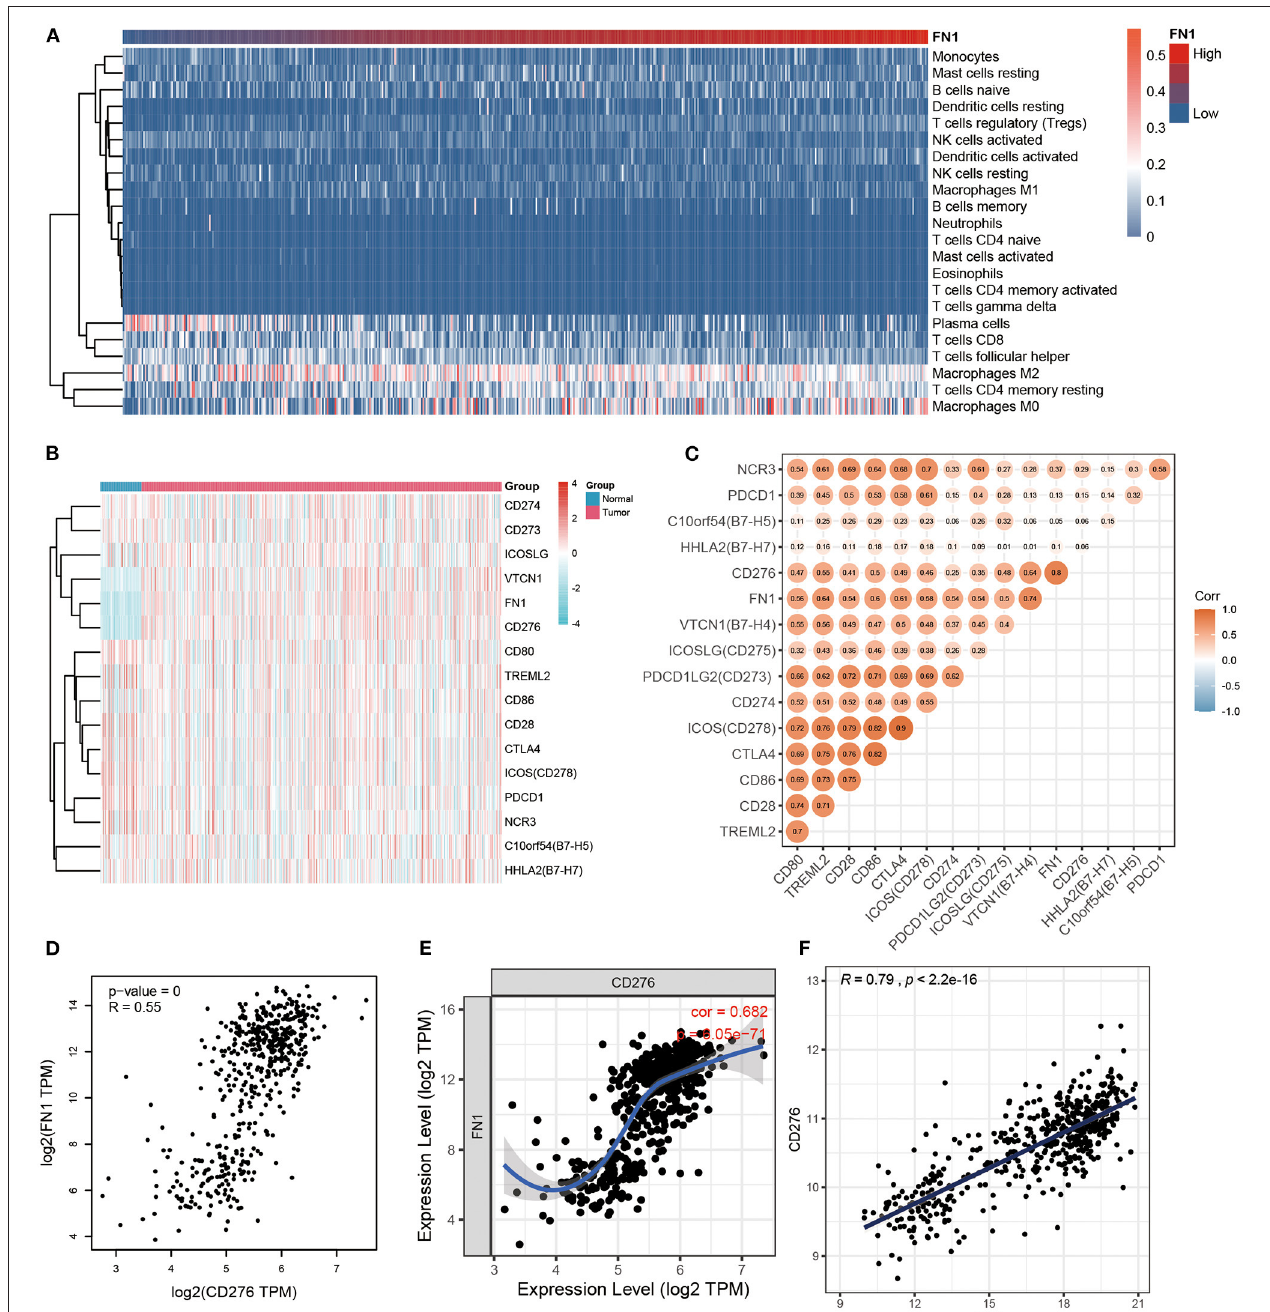
FIGURE 5 | The correlation between FN1 and inflammatory activities. (A) The heatmap of immune infiltration analysis. (B) The coexpression between FN1 and the B7-CD28 ligand-receptor family. (C) The correlation between FN1, CD273, CD274, CD275, CD276, and B7-H4 in THCA cohort. The correlation between FN1 and CD276 analyzed by THCA datasets (D) , TIMER (E), and GEPIA (F)